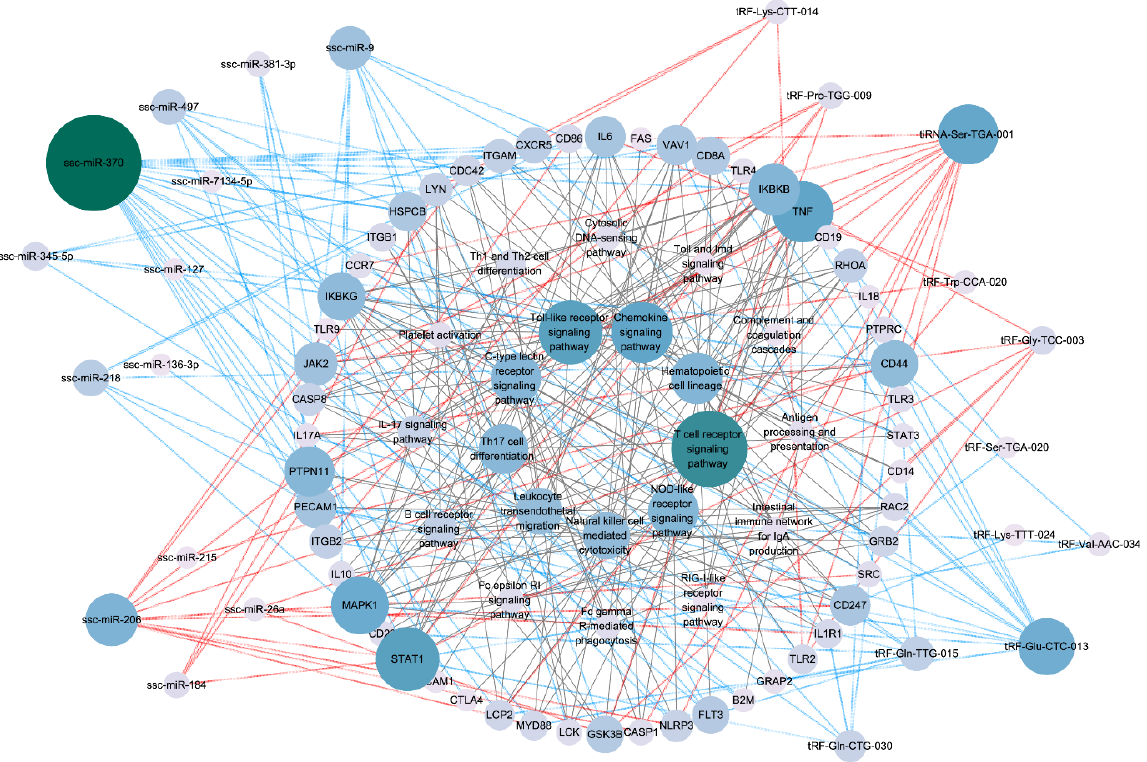
Figure 9. The interaction network of miRNA/tsRNA-target-gene pathway. Red lines represent up-regulated miRNAs/tsRNAs and blue lines represent down-regulated miRNAs/tsRNAs. The circle size and color scales represent the node degree.